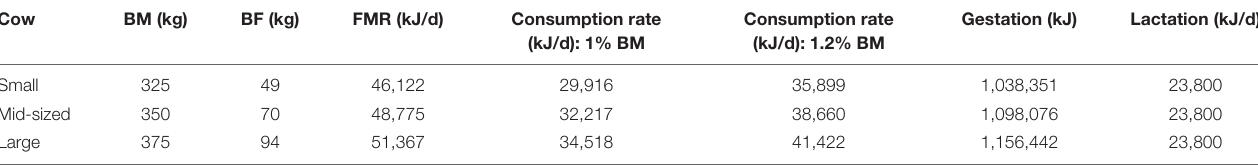
Consumption rate Gestation (kJ) Lactation (kJ/d) (kJ/d): 1% BM (kJ/d): 1.2% BM